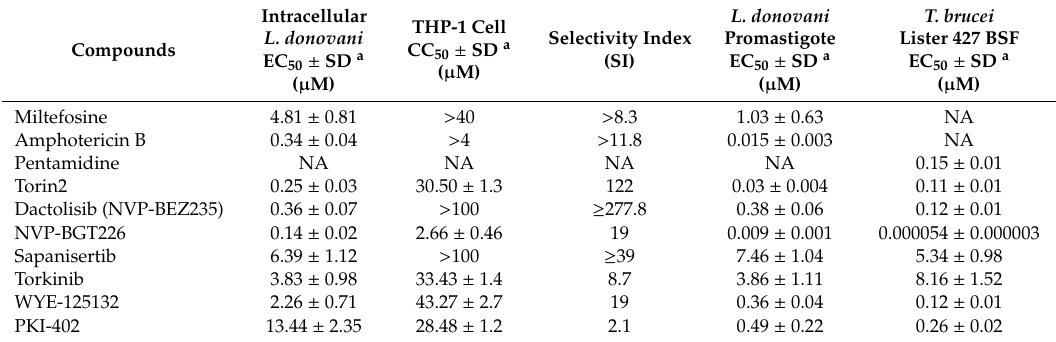
Table 1. E ffi cacy of tested compounds in THP-1 cells infected with intracellular L. donovani, L. donovani promastigote growth; and T. brucei bloodstream form.